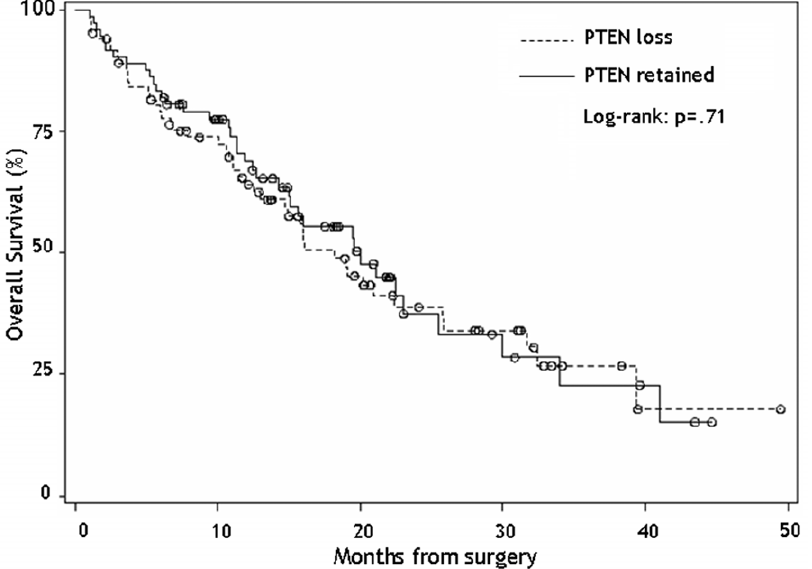
Figure 3. Kaplan-Meir overall 260 survival functions for newly diagnosed glioblastoma patients according to PTEN expression (dashed: PTEN loss, solid: PTEN